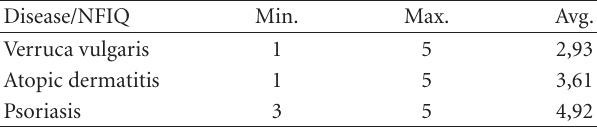
Table 1: The acquired database NFIQ rate testing